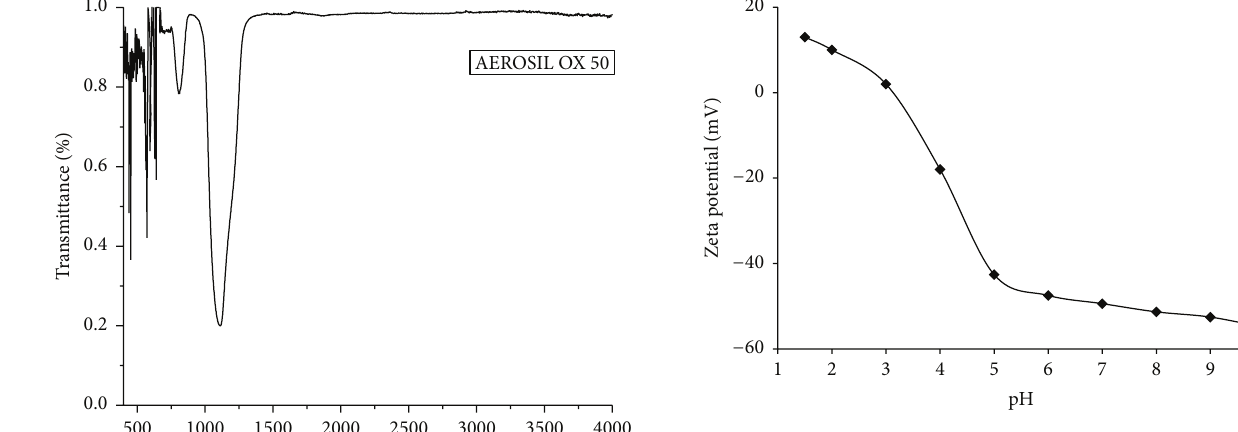
Figure 2: Zeta potential of 1% aqueous dispersion AEROSIL OX 50, measured in 1 × 10 −3 M KCl. The error percentage was about